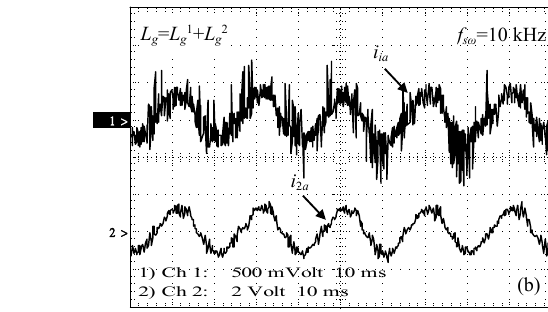
operation; ( b ) measured power converter current i ia (1 A/100 mV) and grid current i 2a (1 A/100 mV)